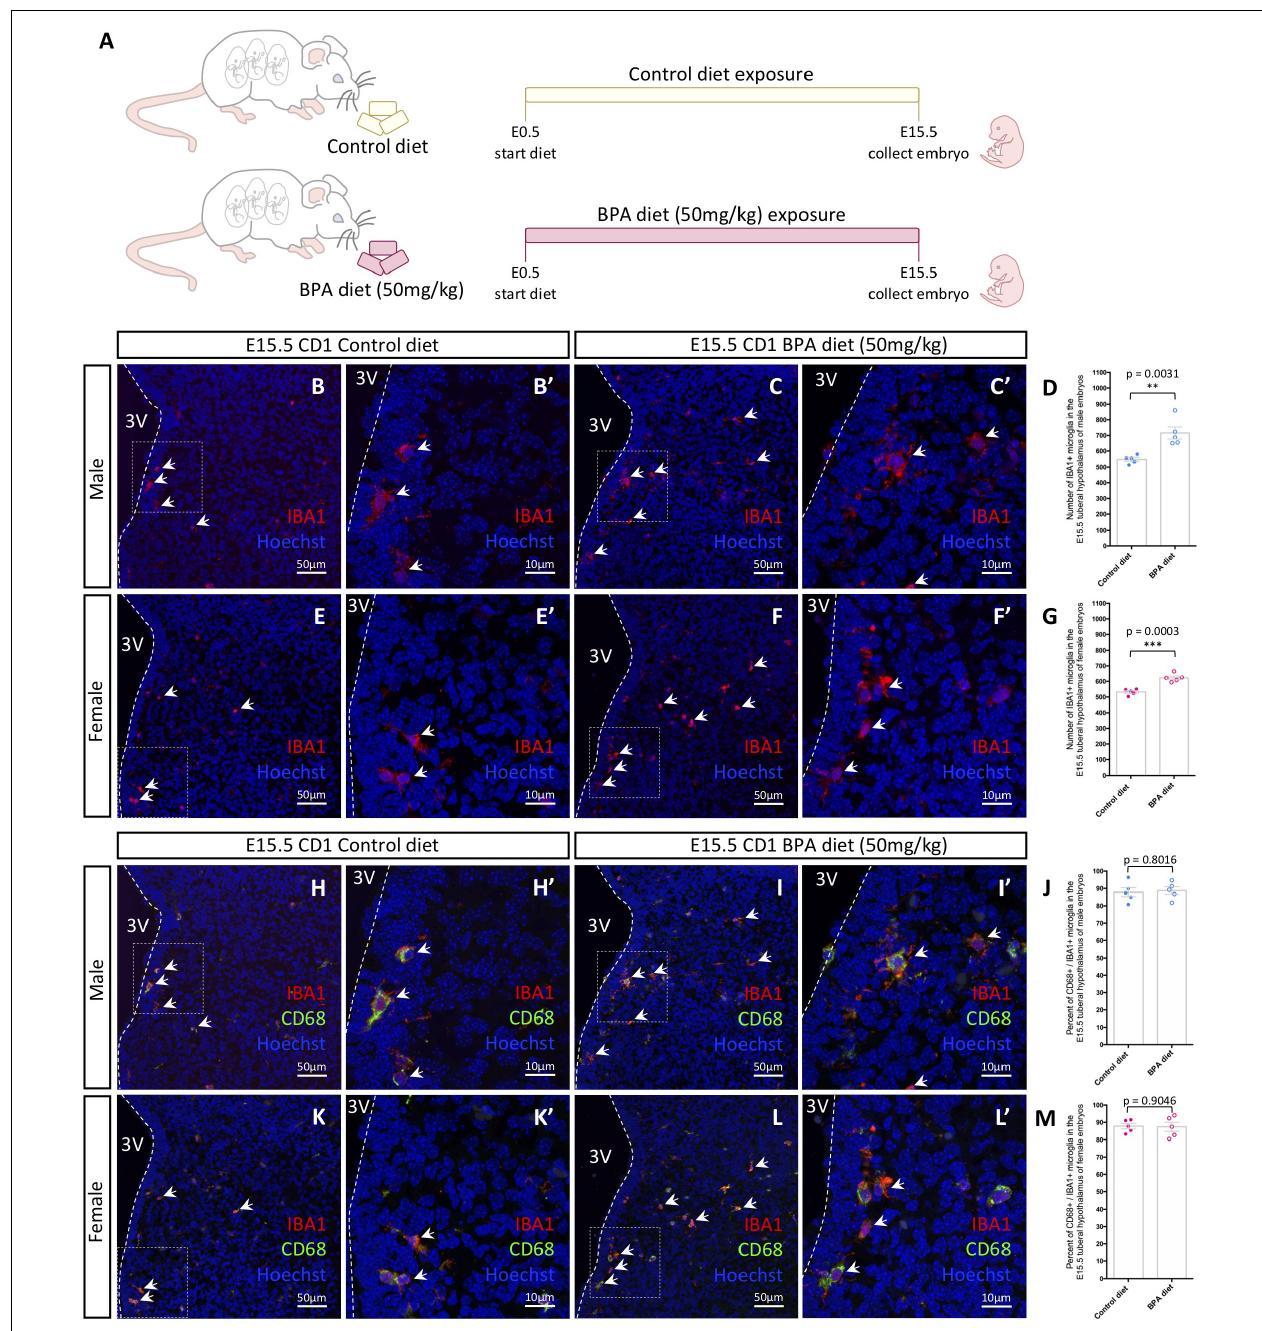
FIGURE 1 | Embryonic hypothalamic microglia are responsive to gestational BPA exposure. (A) Schematic diagraming gestational BPA exposure paradigm. (B–C (cid:48) ) IBA1 and Hoechst staining in the E15.5 tuberal hypothalamus of control (B,B (cid:48) ) and BPA exposed (C,C (cid:48) ) male embryos at low (B,C) and high (B (cid:48) ,C (cid:48) ) magnification. (D) Quantification of the number of IBA1 + microglia in the E15.5 tuberal hypothalamus of control and BPA exposed male embryos ( n = 5; p = 0.0031). (E–F (cid:48) ) IBA1 and Hoechst staining in the E15.5 tuberal hypothalamus of control (E,E (cid:48) ) and BPA exposed (F,F (cid:48) ) female embryos at low (E,F) and high (E (cid:48) ,F (cid:48) ) magnification. (G) Quantification of the number of IBA1 + microglia in the E15.5 tuberal hypothalamus of control and BPA exposed female embryos ( n = 5; p = 0.0003). (H–I (cid:48) ) IBA1, CD68, and Hoechst staining in the E15.5 tuberal hypothalamus of control (H,H (cid:48) ) and BPA exposed (I,I (cid:48) ) male embryos at low (H,I) and high (H (cid:48) ,I (cid:48) ) magnification. (J) Quantification of the percent CD68/IBA1 double-positive microglia in the E15.5 tuberal hypothalamus of control and BPA exposed male embryos ( n = 5; p = 0.8016). (K–L (cid:48) ) IBA1, CD68, and Hoechst staining in the E15.5 tuberal hypothalamus of control (K,K (cid:48) ) and BPA exposed (L,L (cid:48) ) female embryos at low (K,L) and high (K (cid:48) ,L (cid:48) ) magnification. (M) Quantification of the percent CD68/IBA1 double-positive microglia in the E15.5 tuberal hypothalamus of control and BPA exposed female embryos ( n = 5; p = 0.9046). (B–C (cid:48) ,E–F (cid:48) ,H–I (cid:48) ,K–L (cid:48) ) White arrows point to microglia. White dashed lines mark the third ventricle (3V). (D,G,J,M) Counts represent means ± SEM and were analyzed by a Student’s t -test. ∗∗ p < 0.01, ∗∗∗ p < 0.001.